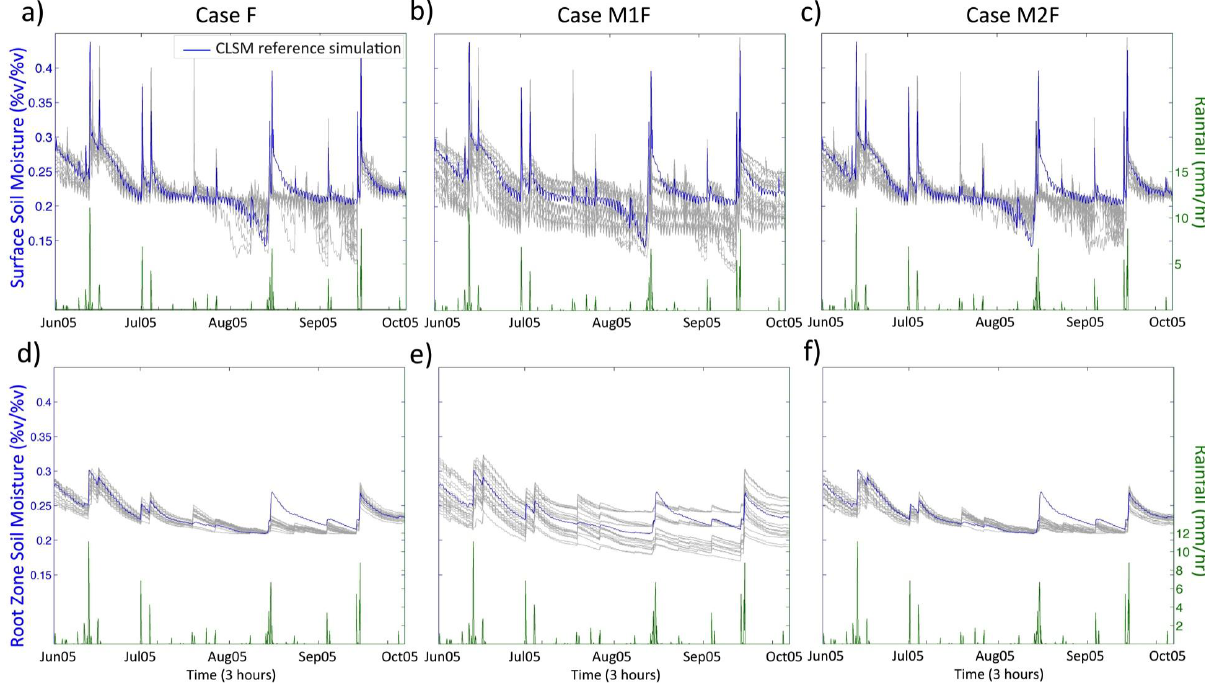
Fig. 7. Surface (a, b, c) and root zone soil moisture (d, e, f) time series during the warm season of 2005 (June to September) for the grid cell shown in Fig. 5, located in the eastern region of the study area. Panels (a) and (d) show the experiment where only rainfall forcing uncertainty is introduced; panels (b) and (e) show the experiment that combines rainfall forcing uncertainty with model uncertainty by perturbing model parameters; and panels (c) and (f) show the experiment that combines rainfall forcing uncertainty with model uncertainty by perturbing prognostics. Time series of rainfall are also shown on the second axis of each panel.